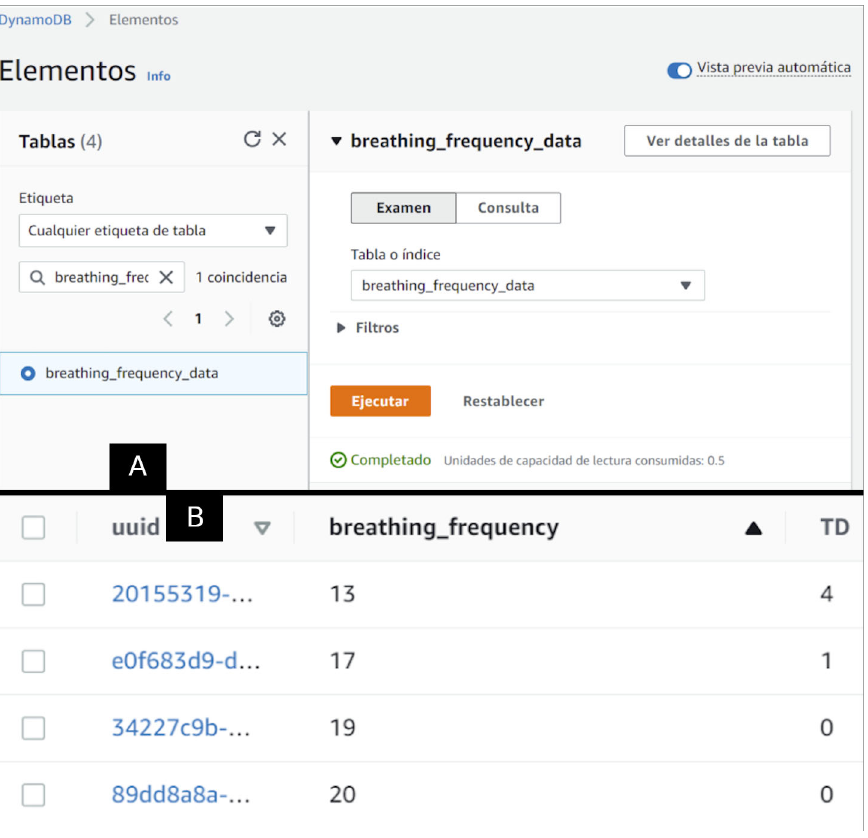
Figure 6. In panel A, the configuration of the table in the AWS Dynamo DB to store the estimated operation points. In Panel B, some operation point